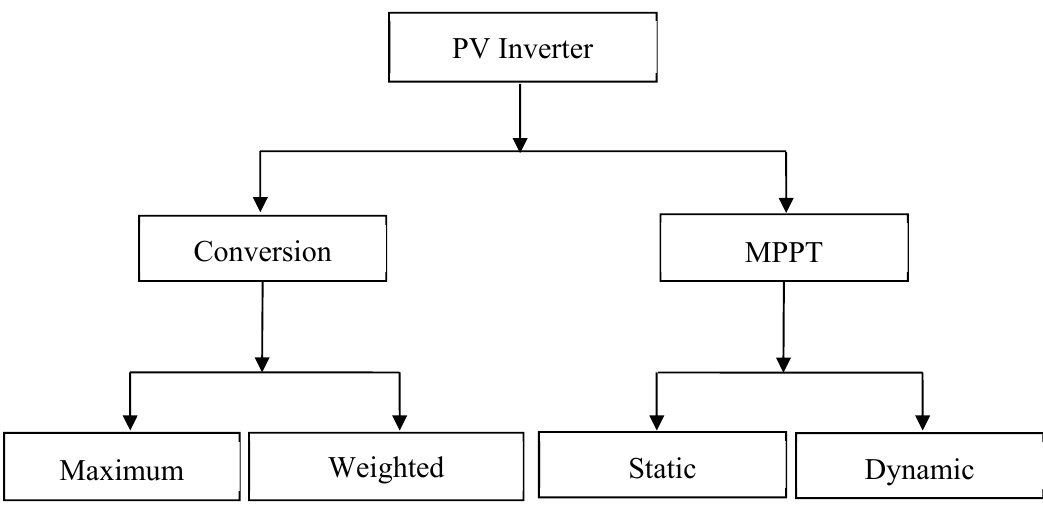
Figure 1. Tree diagram of PV inverter efficiency [11].